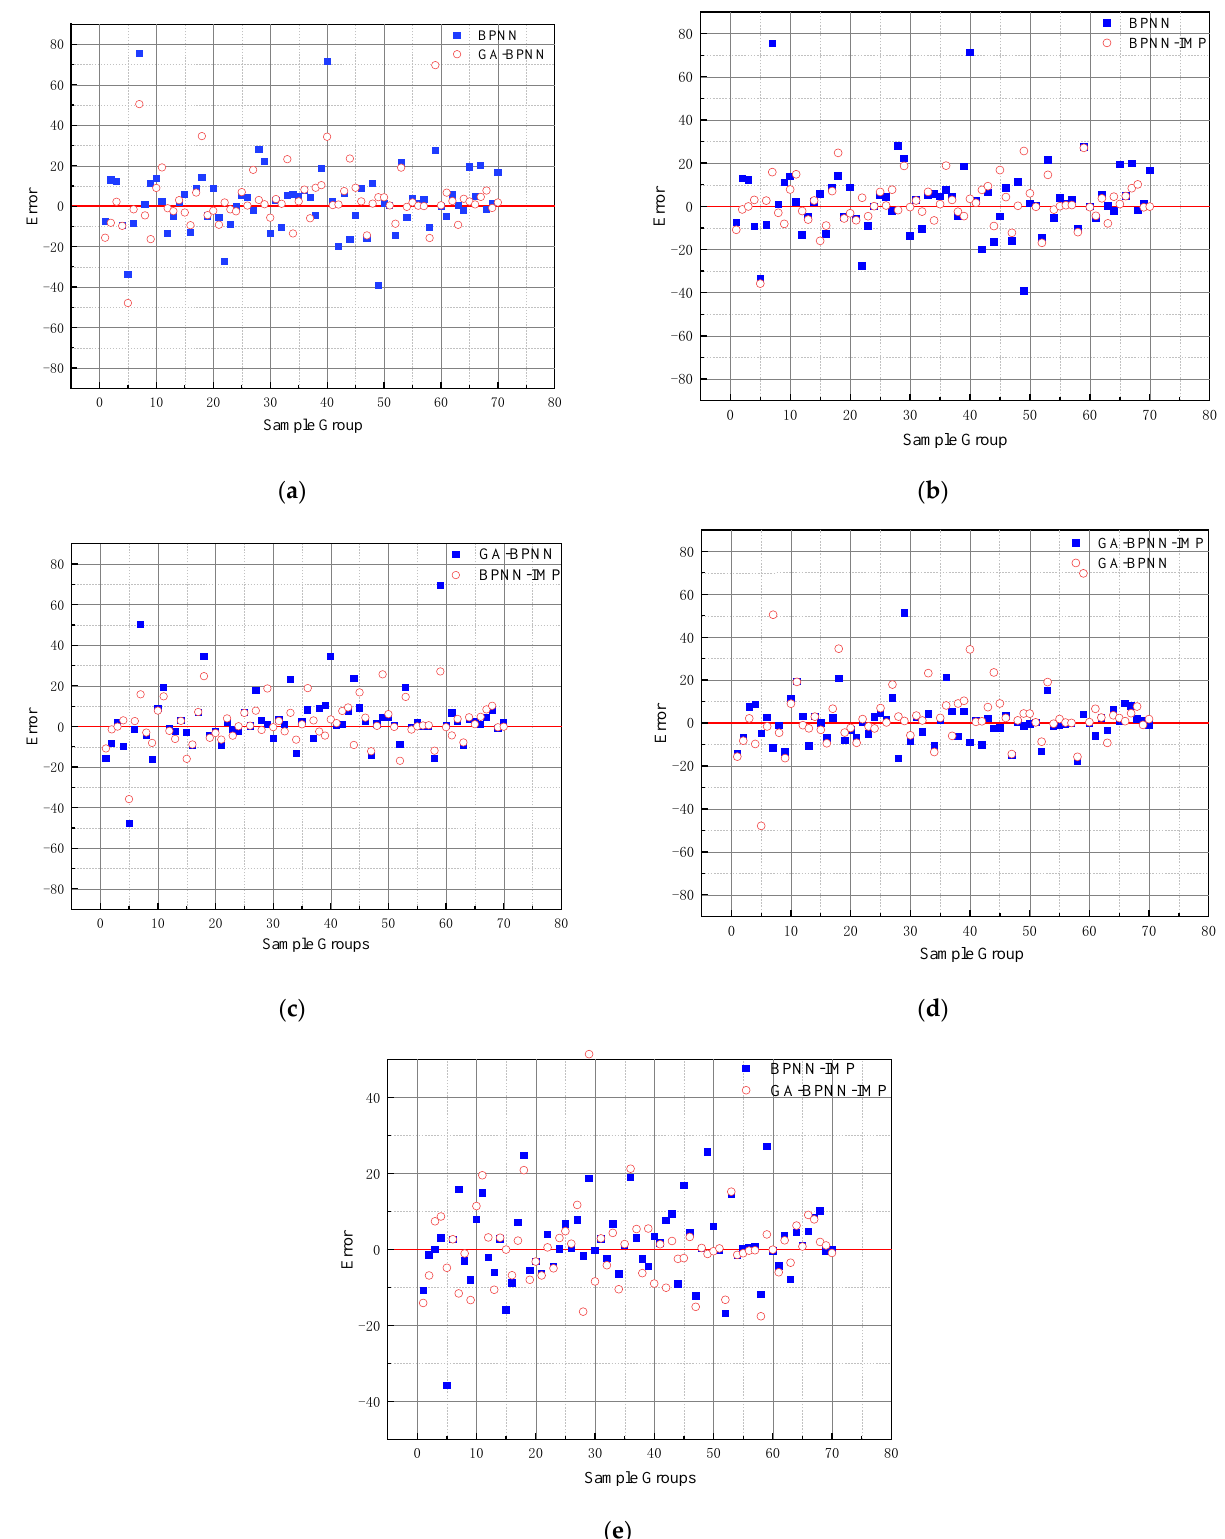
Figure 8. Error distribution between different models. ( a ) Error comparison between BPNN and GA-BPNN. ( b ) Error comparison between BPNN and optimized BPNN. ( c ) Error comparison between optimized BPNN and GA-BPNN. ( d ) Error comparison between GA-BPNN and optimized GA-BPNN. ( e ) Error comparison between optimized BPNN and optimized GA-BPNN.